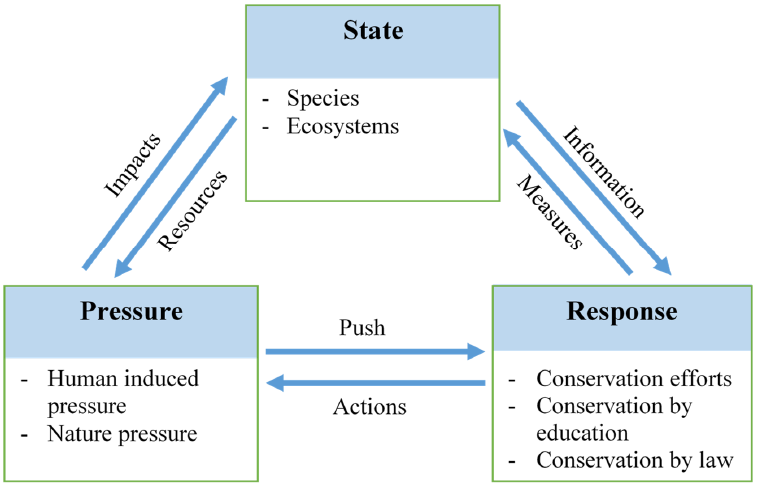
Figure 1. Adapted PSR model for evaluating biodiversity conservation.